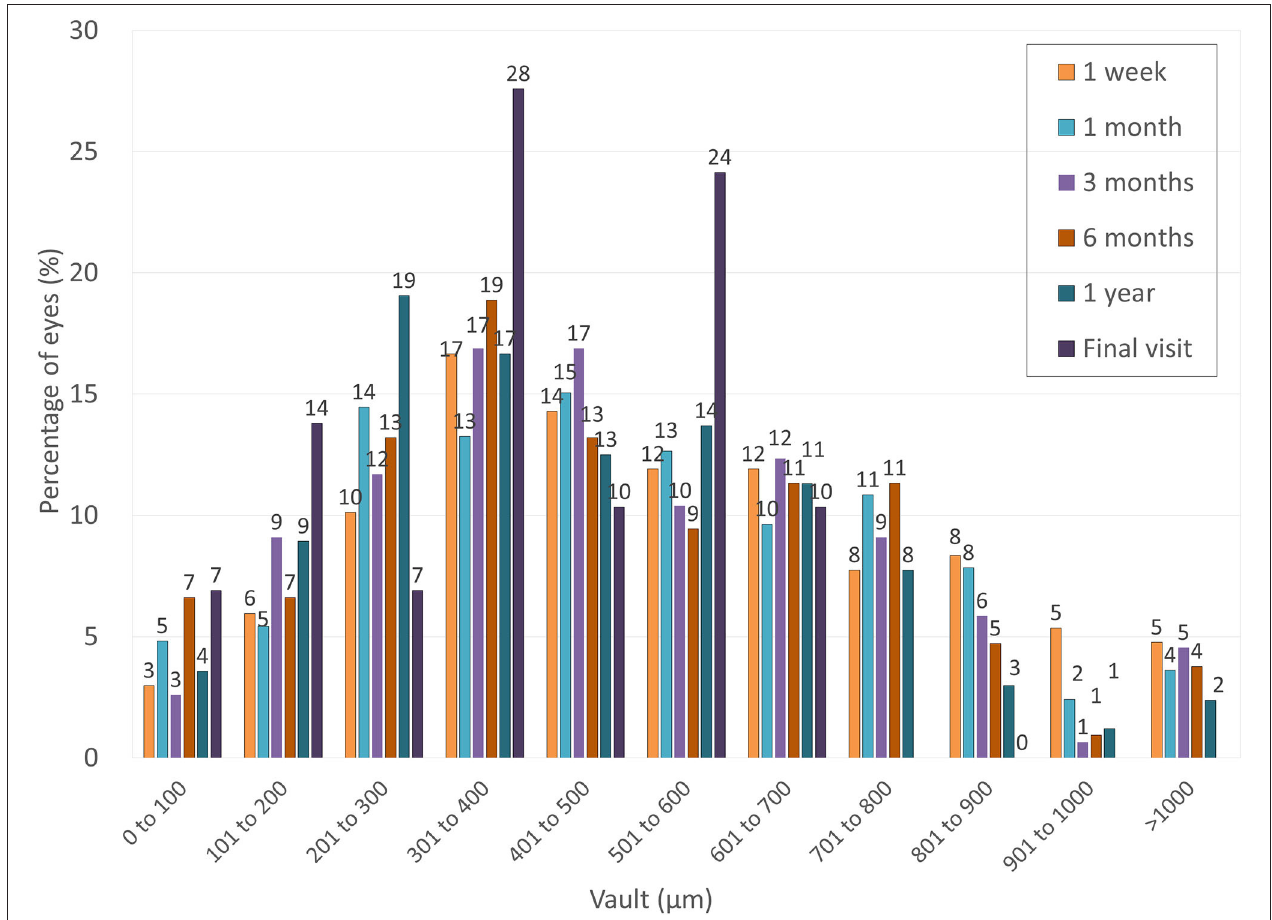
FIGURE 3 | Distribution of eyes according to the vault after ICL implantation in eyes with low